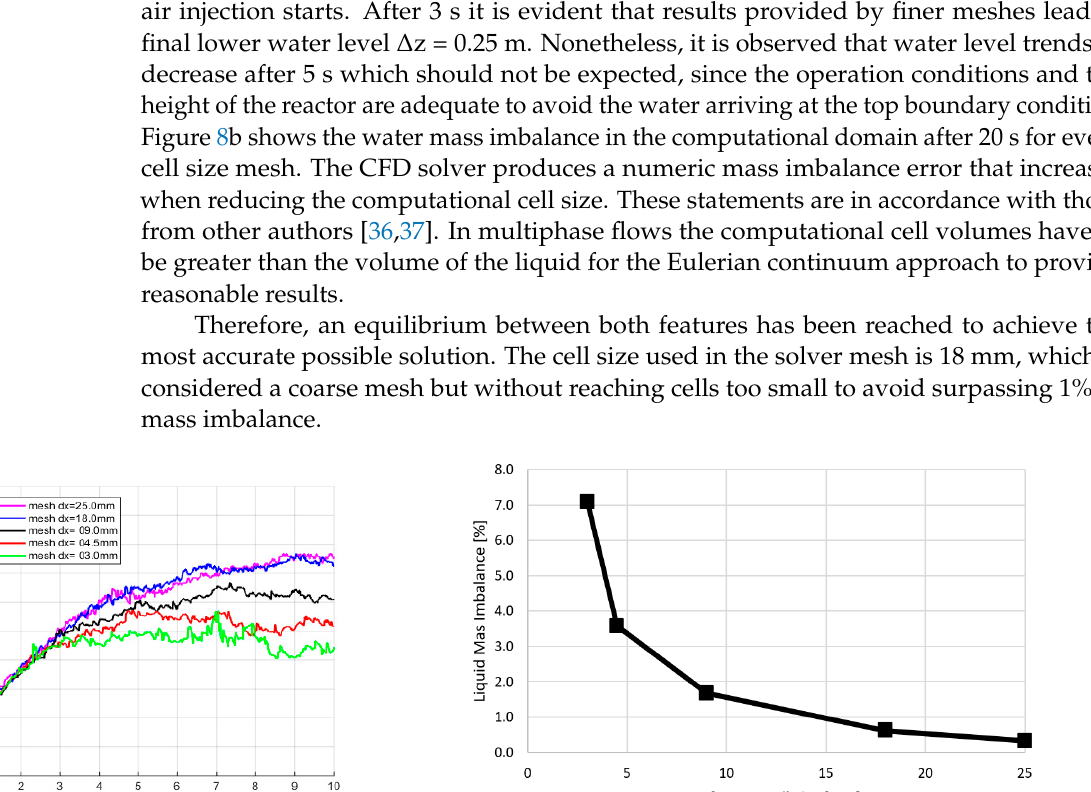
Figure 8. Mesh independence study. ( a ) Variation of water column height. ( b ) Liquid mass imbalance.